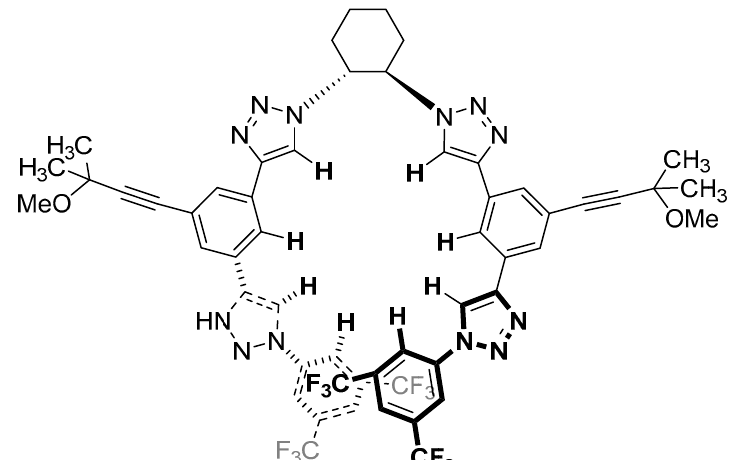
Figure 5. Catalyst A structure.